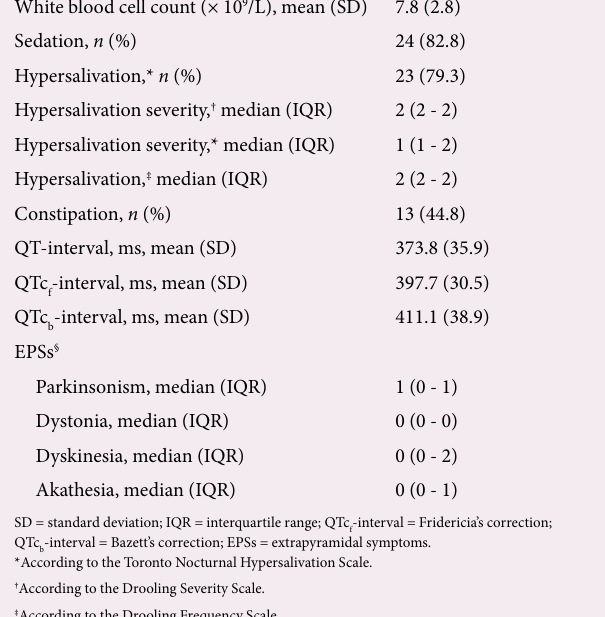
Table 3. Other adverse effects fwith clozapine ( N